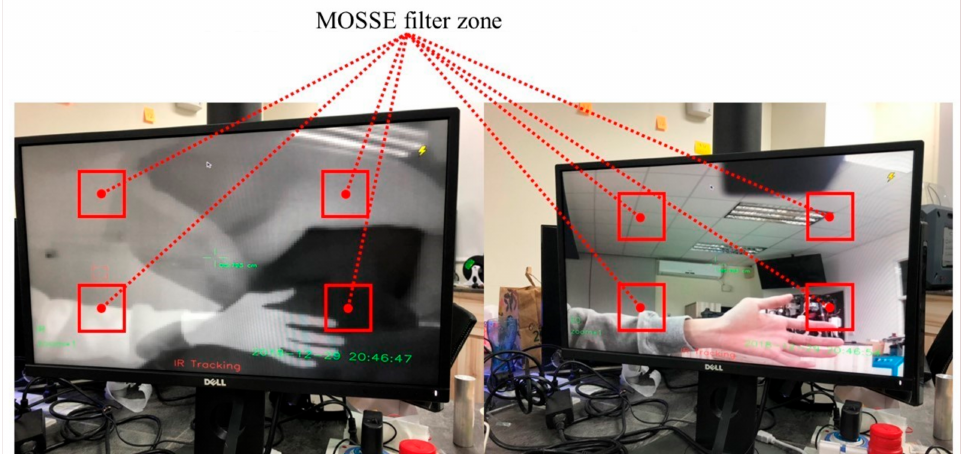
Figure 3. MOSSE filter zone and SiamFC